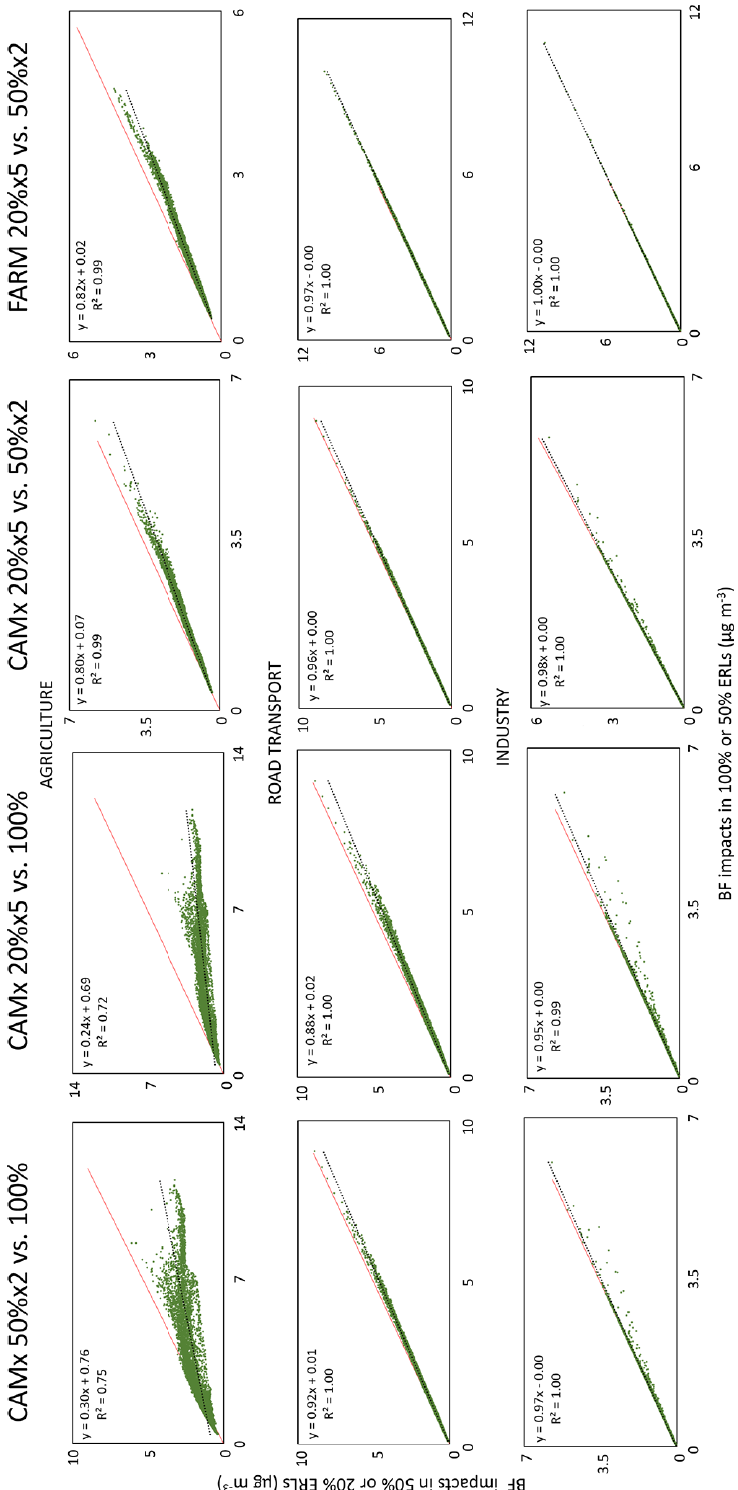
Figure 4. Scatter plots of the single grid cell BF source impacts (CAMx and FARM) on PM 10 between 100%, 50% (multiplied by 2) and 20% (multiplied by 5) ERLs for AGR, TRA and IND. Dotted line: regression; red line: identity.